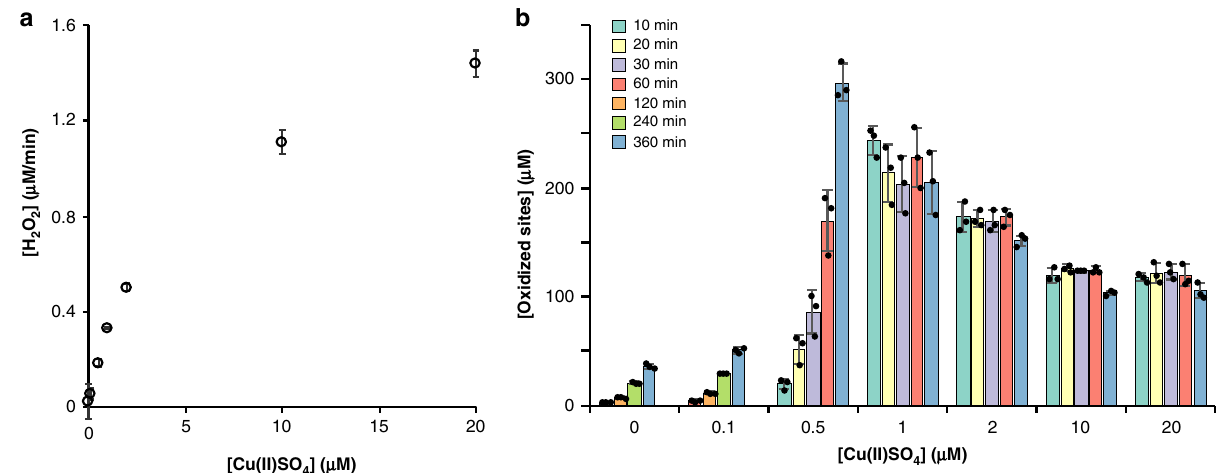
Fig. 7 Effect of free copper on non-enzymatic H 2 O 2 production and Sc AA10C activity. a The graph shows the rate of H 2 O 2 production in reactions containing AscA (50 µ M) and varying amounts of Cu(II)SO 4 (0 – 20 µ M), in sodium phosphate buffer (50 mM, pH 7.0), at 25 °C. b The graph shows the time course release of soluble oxidized products from Avicel (10 g L − 1 ) by Sc AA10C (1 µ M) in presence of AscA (1 mM) and varying amounts of Cu(II)SO 4 (0 – 20 µ M), in sodium phosphate buffer (50 mM, pH 6.0) and incubated in a thermomixer (1000 rpm, 40 °C). Note that soluble oxidized products were not detectable before 60 min incubation for reactions containing 0 µ M and 0.1 μ M of added free copper; therefore, the sampling was adapted (60, 120, 240, and 360 min). Before product quanti fi cation, solubilized cello-oligosaccharides were hydrolyzed by Tf Cel5A, to convert the LPMO products to a mixture of only two oxidized products with a degree of polymerization of 2 and 3 [GlcGlc1A, (Glc) 2 Glc1A], the amounts of which were summed up to yield the concentration of oxidized sites. Error bars show ± s.d. ( n = 3, independent experiments). Source data are provided as a Source Data fi le.